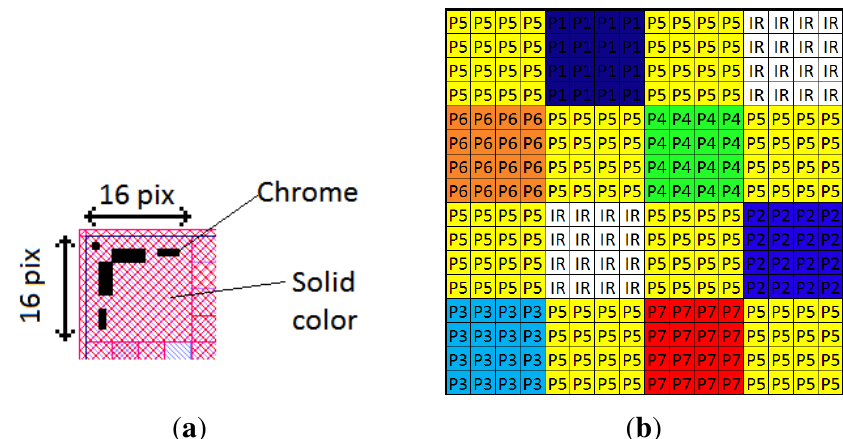
Figure 12. One alignment matrix ( a ), in the top left corner of the filter array; ( b ) Each filter covers 4 × 4 pixels of the